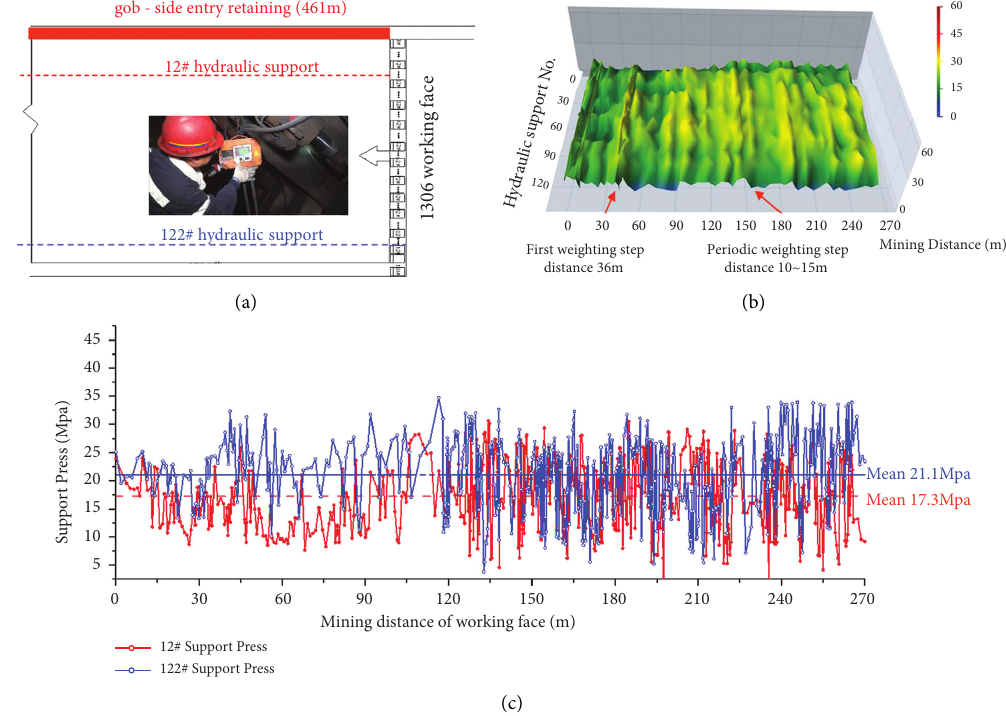
Figure 14: The hydraulic support pressure monitoring. (a) Schematic diagram of working face pressure sensor. (b) Three-dimensional distribution diagram of time-distance pressure of hydraulic support. (c) Comparison of pressure curves of specific hydraulic supports.